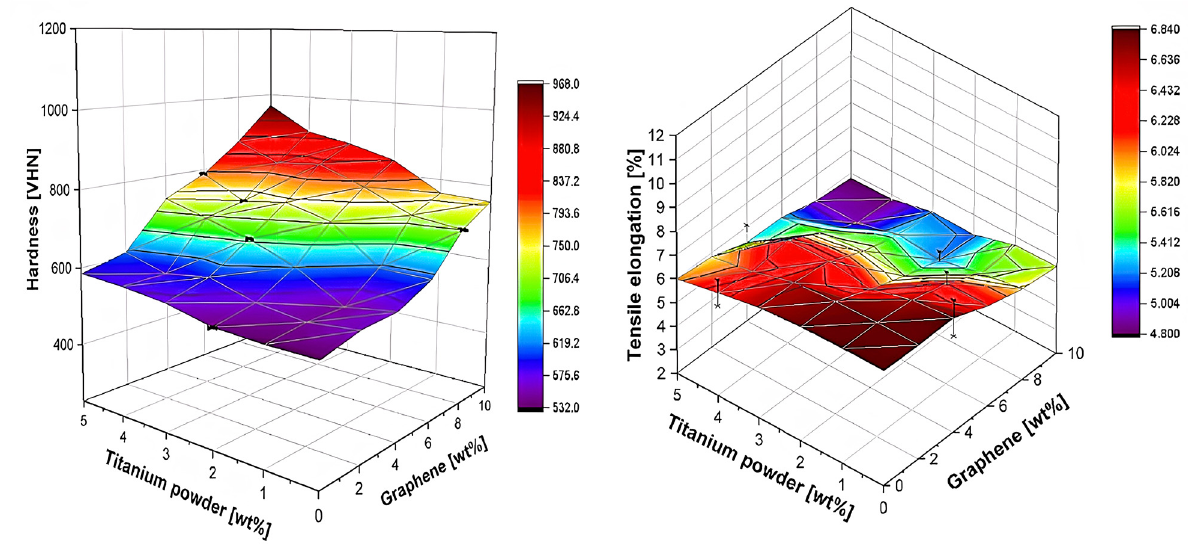
Figure 13. Prediction results of hardness and tenisle elongation of PEEK/C/Ti hybrid nanocomposites. Reprinted from Ref. [101], copyright 2022, with permission from Elsevier.